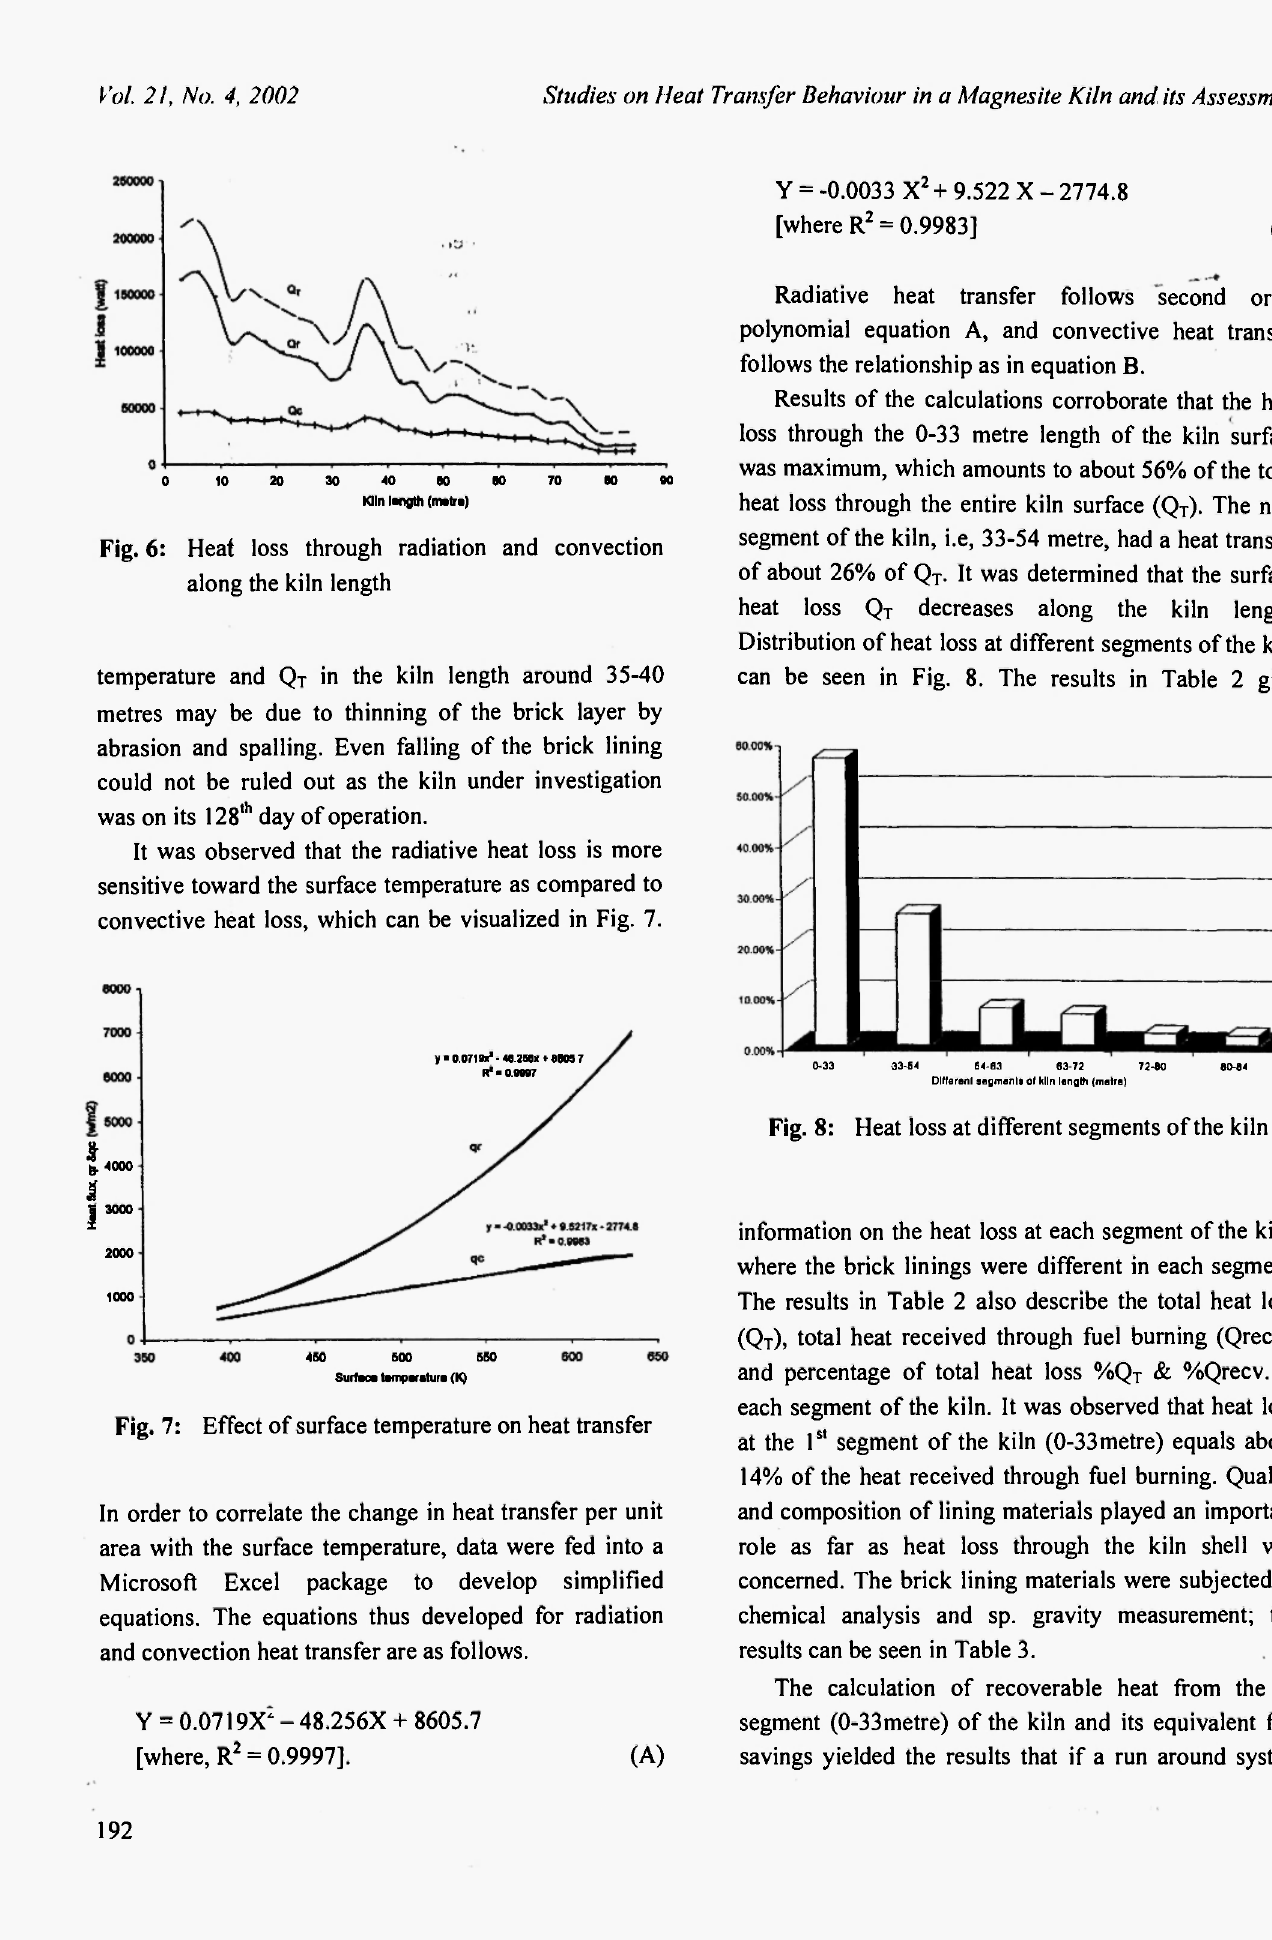
Fig. 7: Effect of surface temperature on heat transfer